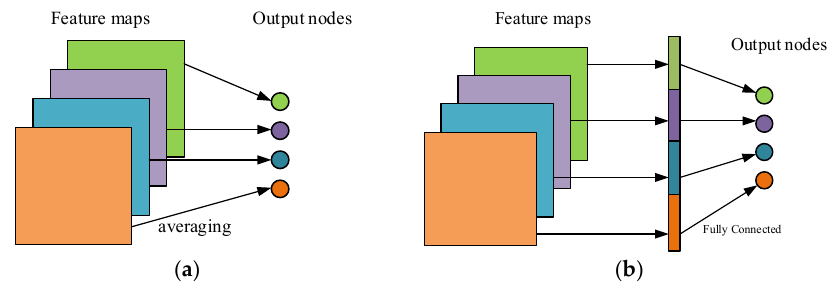
Figure 3. Global pooling versus full connection. ( a ) Global Average Pooling; ( b ) Fully connected Layers.